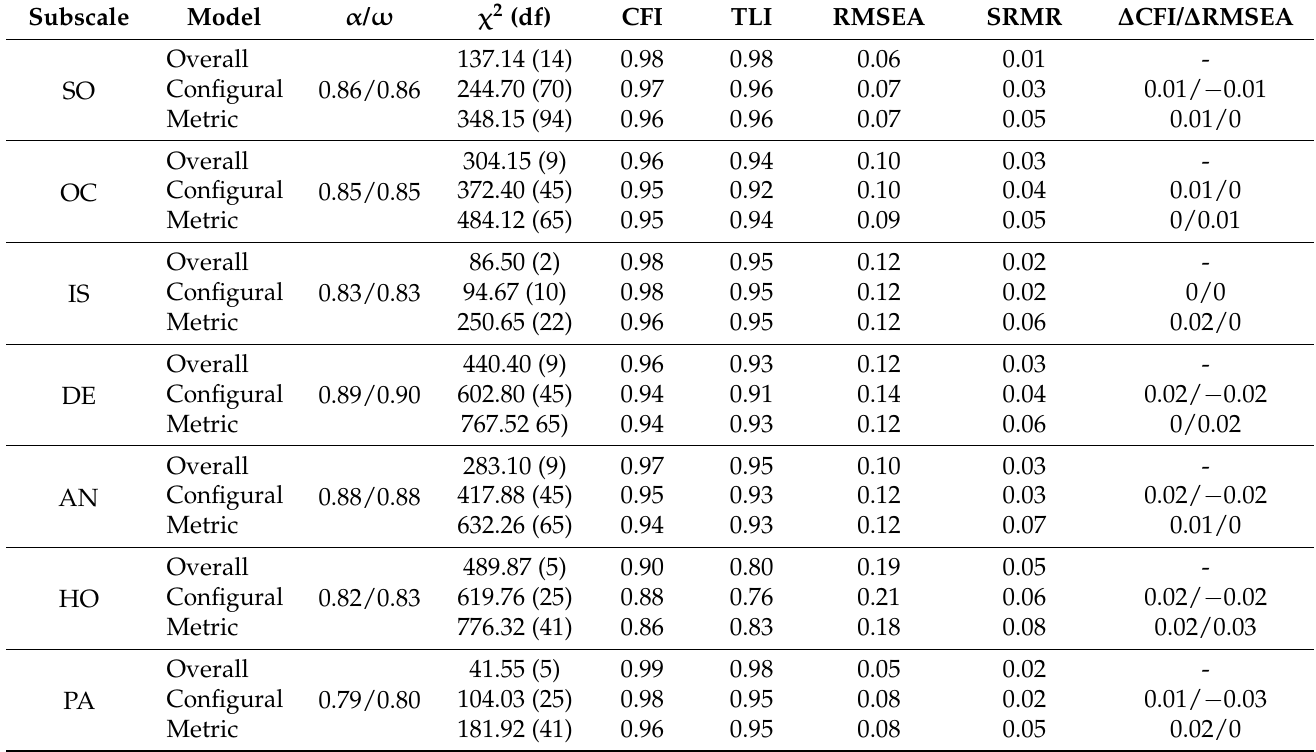
Table 2. Measurement invariance of the BSI domains across five